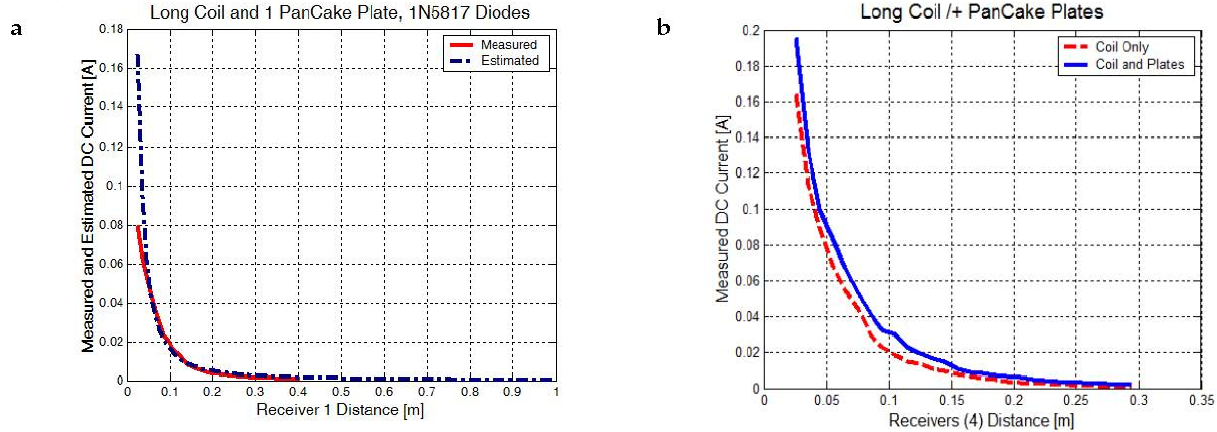
Figure 6. ( a ) Measured DC current for one pancake plate (C1 configuration) and a rectifier made from four 1N5817 diodes. ( b ) Measured DC current for four transducer plates, a long RF coil case (C2 configuration) or both an RF coil and pancake plates (C3 configuration).